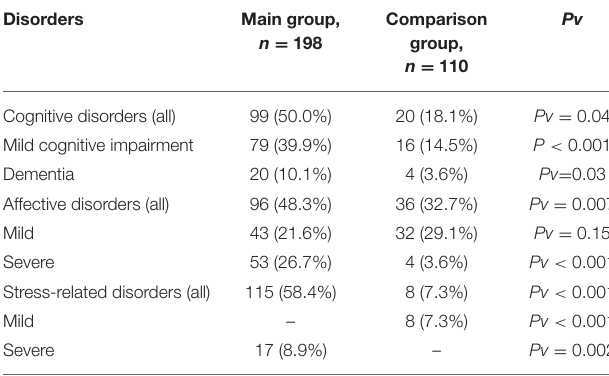
TABLE 3 | Assessment of cognitive, affective, and stress-related disorders in the main group (clean-up workers) and the comparison group. Disorders